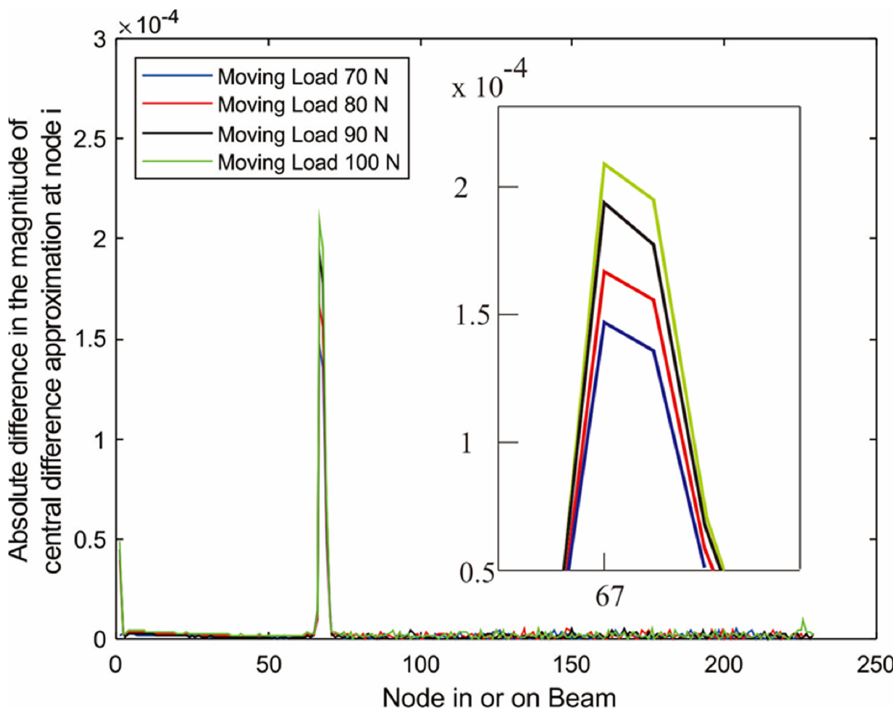
Figure 14. Absolute difference between the central difference approximation of displacement of the uncracked and the cracked (Node 70) cantilever beam subjected to moving load.